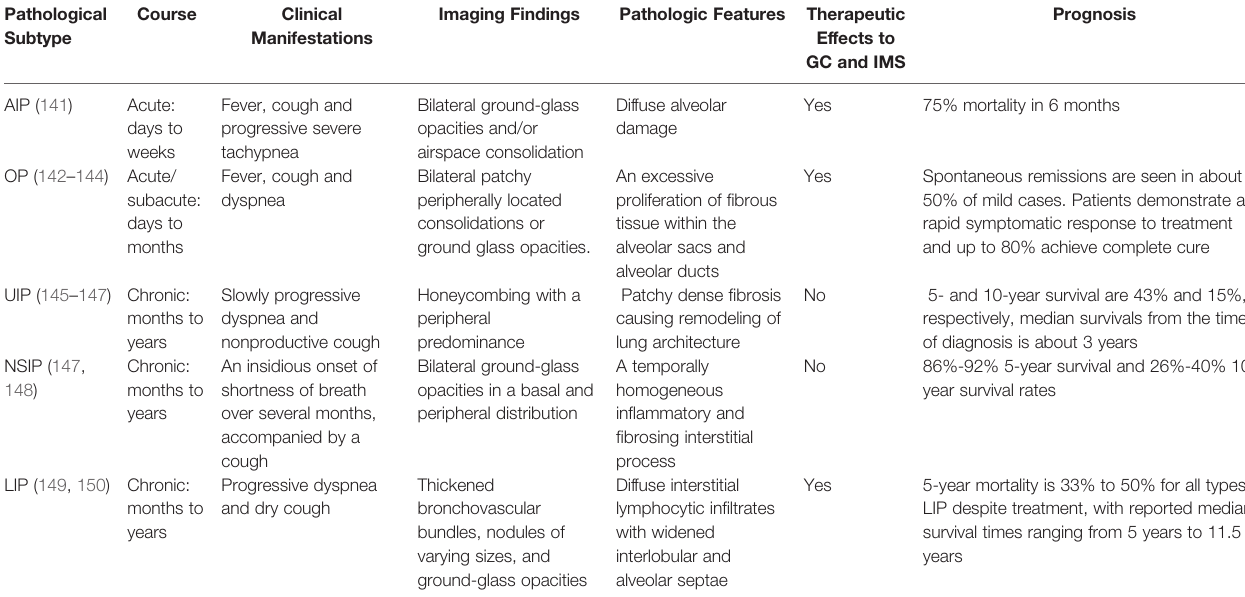
TABLE 3 | Clinical Characteristics, Response to Therapy and Prognosis of CTD-ILD Subtypes. Pathological Subtype